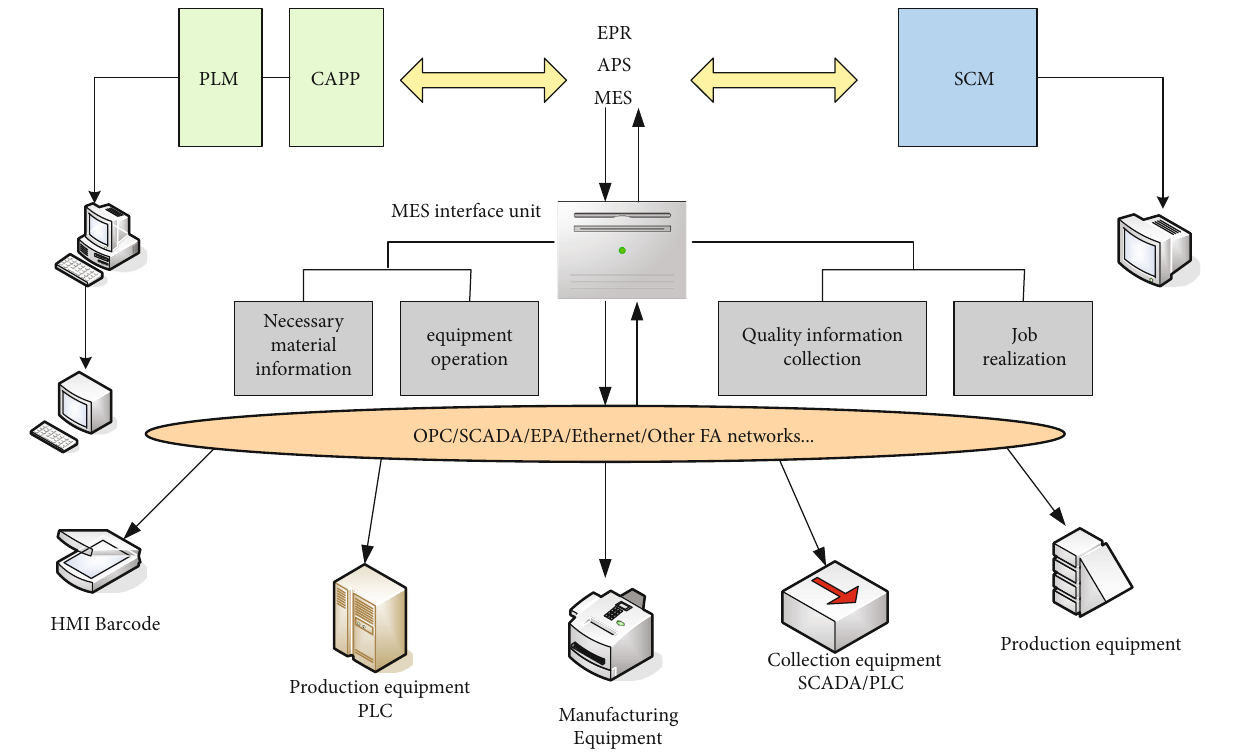
Figure 1: PR process entity